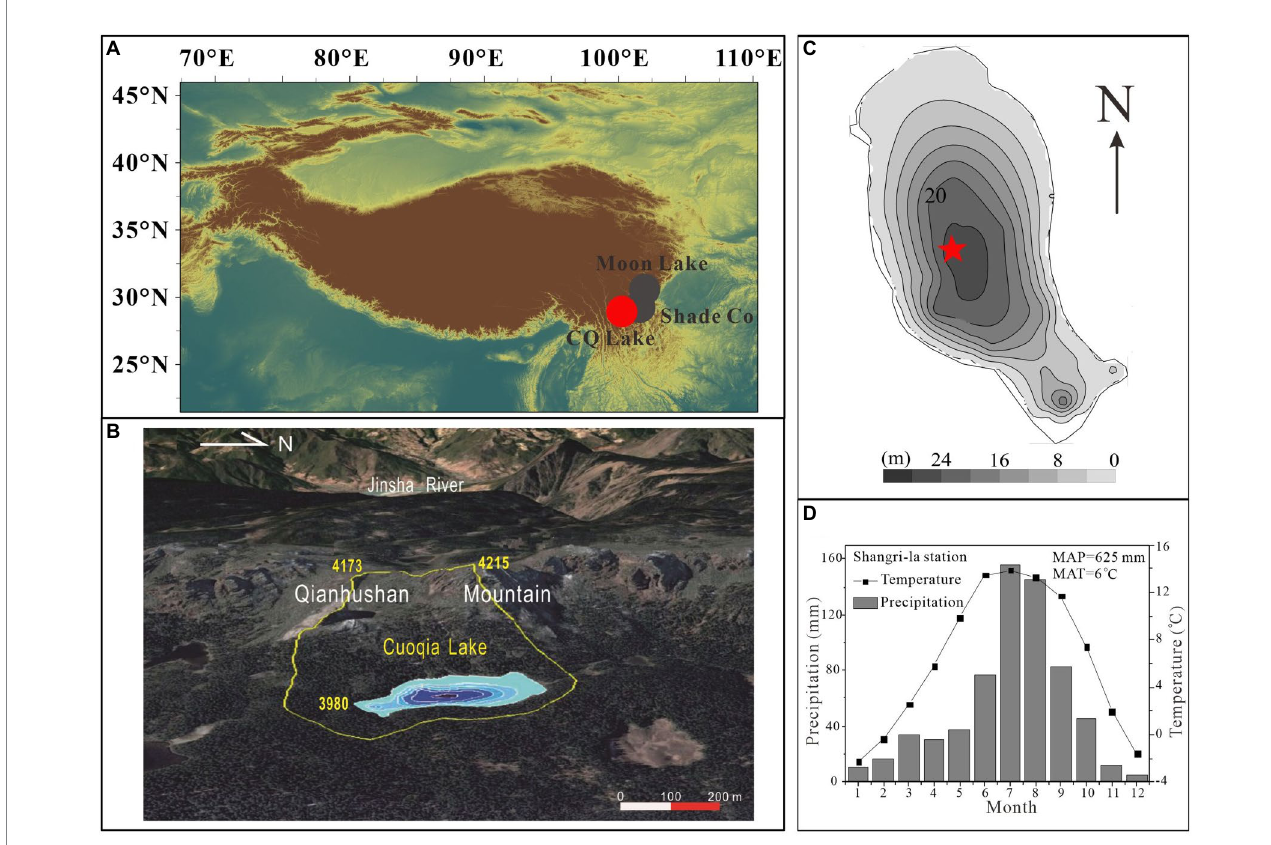
FIGURE 1 Location and setting. (A) Map showing the location of the study site Cuoqia Lake (CQ Lake, red dots) and nearby Moon Lake and Shade Co (gray dots) in the southeast Tibetan Plateau. (B) topography and catchment (circled by yellow line) of CQ Lake, base map from Google Earth [modified from Li et al. (2021)]. (C) Bathymetry of the CQ Lake and locations of the sediment cores (red asterisks). (D) Mean monthly temperature and precipitation at the Shangri- la Meteorological Station, Yunnan Province, China (data retrieved from the Meteorological Administration of China,